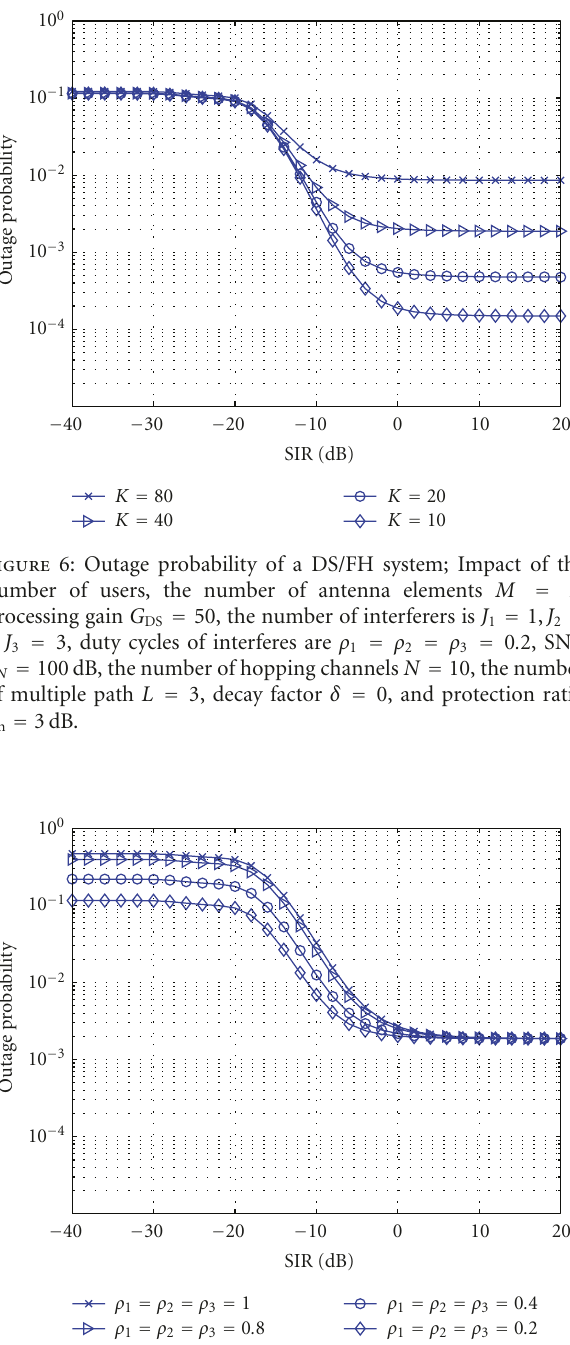
Figure 7: Outage probability of a DS/FH system, impact of the duty cycle of interferers, the number of antenna elements M = 2, processing gain G DS = 50, the number of users K = 40, the number of interferers is J 1 = 1, J 2 = 2, J 3 = 3, SNR Γ N = 100 dB, the number of hopping channels N = 10, the number of multiple path L = 3, decay factor δ = 0, and protection ratio r th = 3 dB.